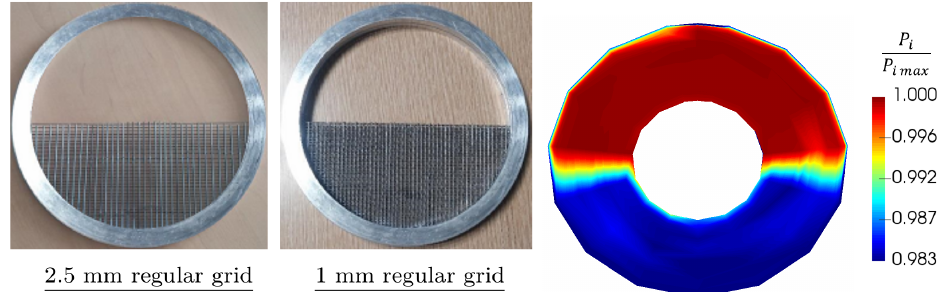
Figure 7. Distortion grids and example of measured total pressure pattern.